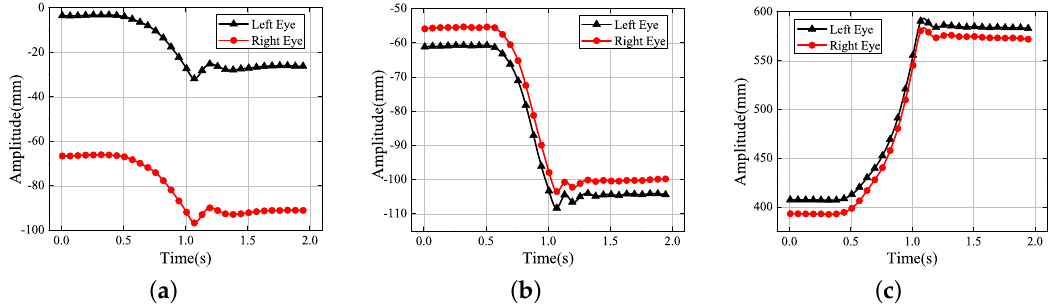
Figure 17. Experimental results obtained during car acceleration: ( a ) X axis; ( b ) Y axis; ( c ) Z axis.